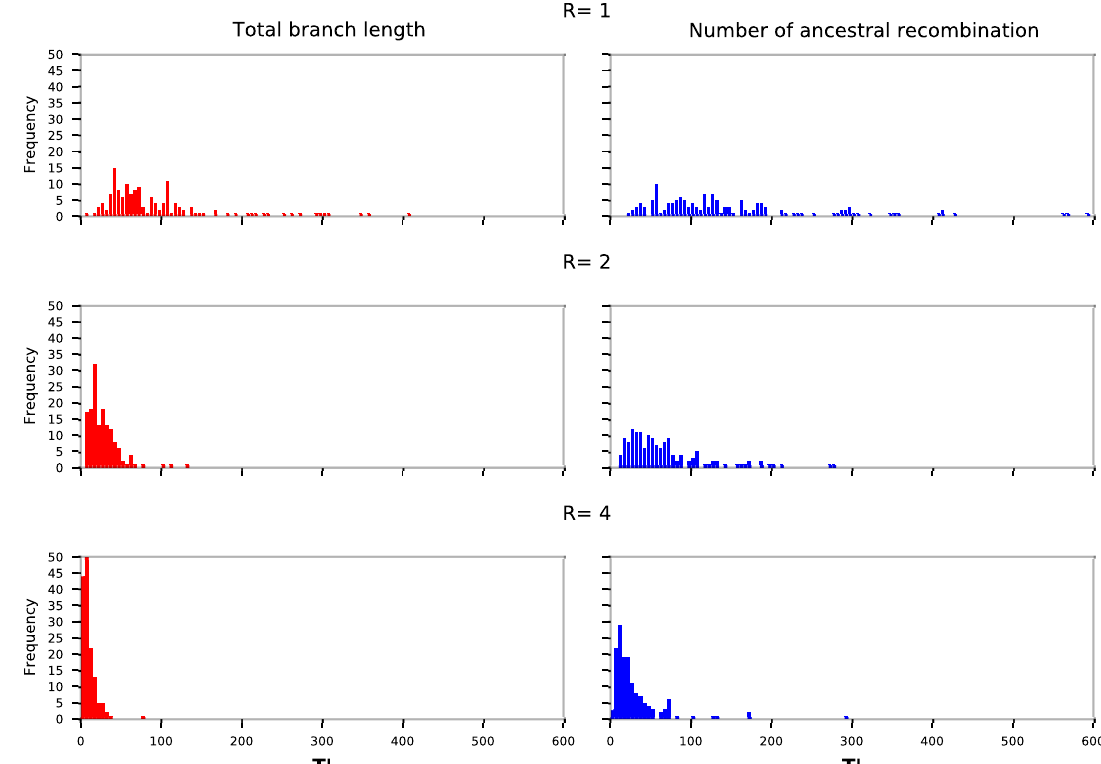
Fig 1. Plots of T 0 , the first time lag with autocorrelation � 0, for the total branch length and number of ancestral recombinations for all 450 data sets.